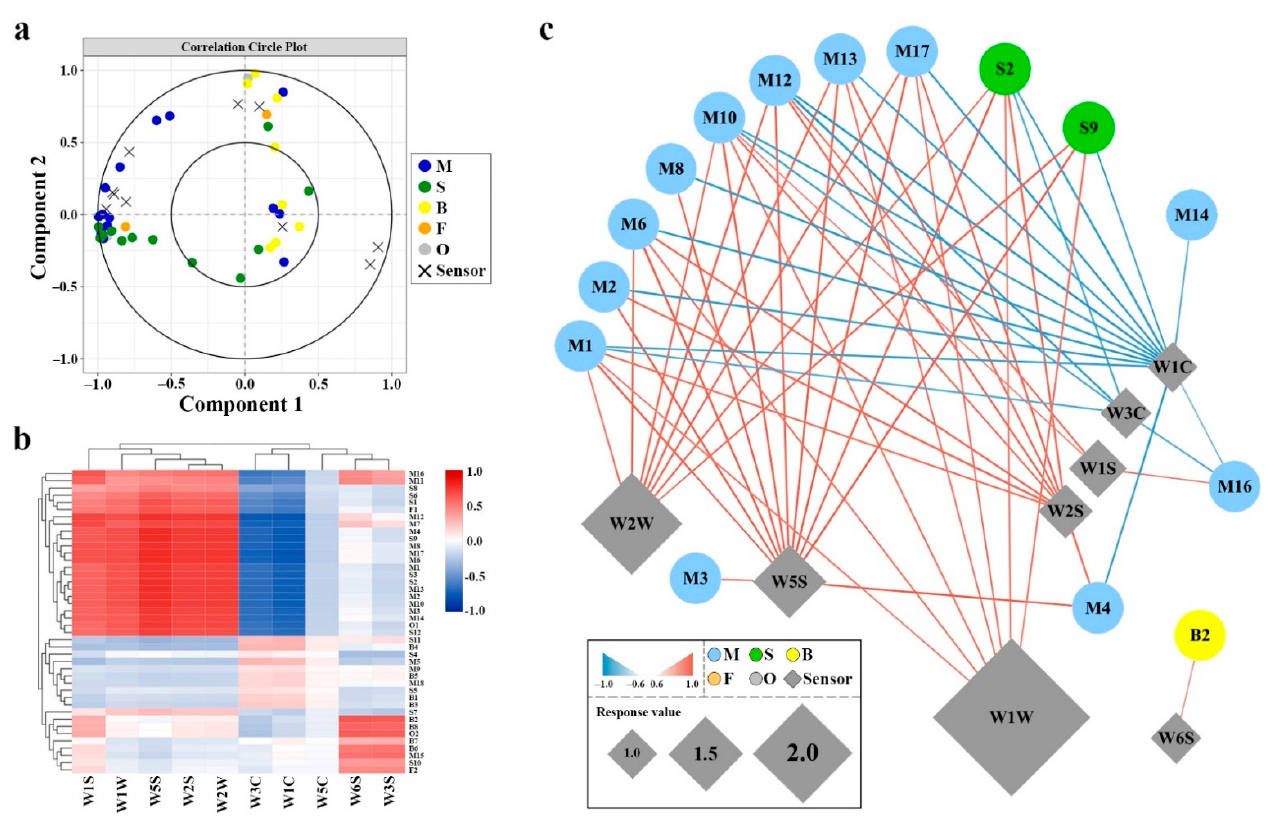
Figure 4. PLS regression of VOCs data obtained by HS–SPME–GC–MS and E-nose analysis. Plot ( a ) reports the loading plot of the PLS regression analysis assessed with the HS–SPME–GC–MS and E-nose data. Plot ( b ) shows the heatmap of the PLS correlation coefficients between VOCs and sensors. Plot ( c ) discloses the correlation analysis network based on significance ( p < 0.05). PLS correlations between VOCs detected by HS–SPME–GC–MS and sensors by E-nose. The gradient color coding of the edges and the line thickness denote the level of correlation (0.6–1). Positive and negative correlations are shown by red and blue gradient colors.